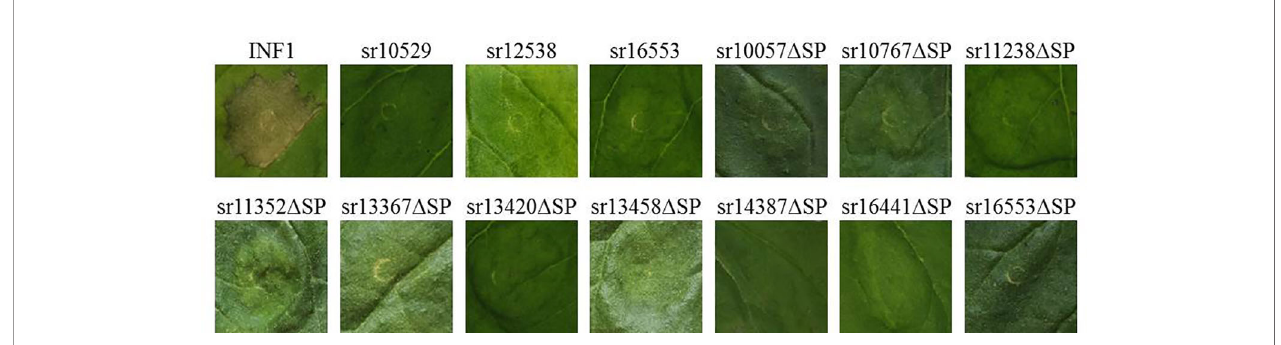
FIGURE 2 | PCD induction assay. Agrobacterium strains carrying constructs with Sporisorium reilianum f. sp. zeae (SRZ) effectors were in fi ltrated in N. benthamiana . The results were evaluated at 3, 4, and 5 days after in fi ltration and compared to that of Infestin1 (INF1). None of the constructs could induce cell death under our experimental conditions. Pictures were taken at 4 days after in